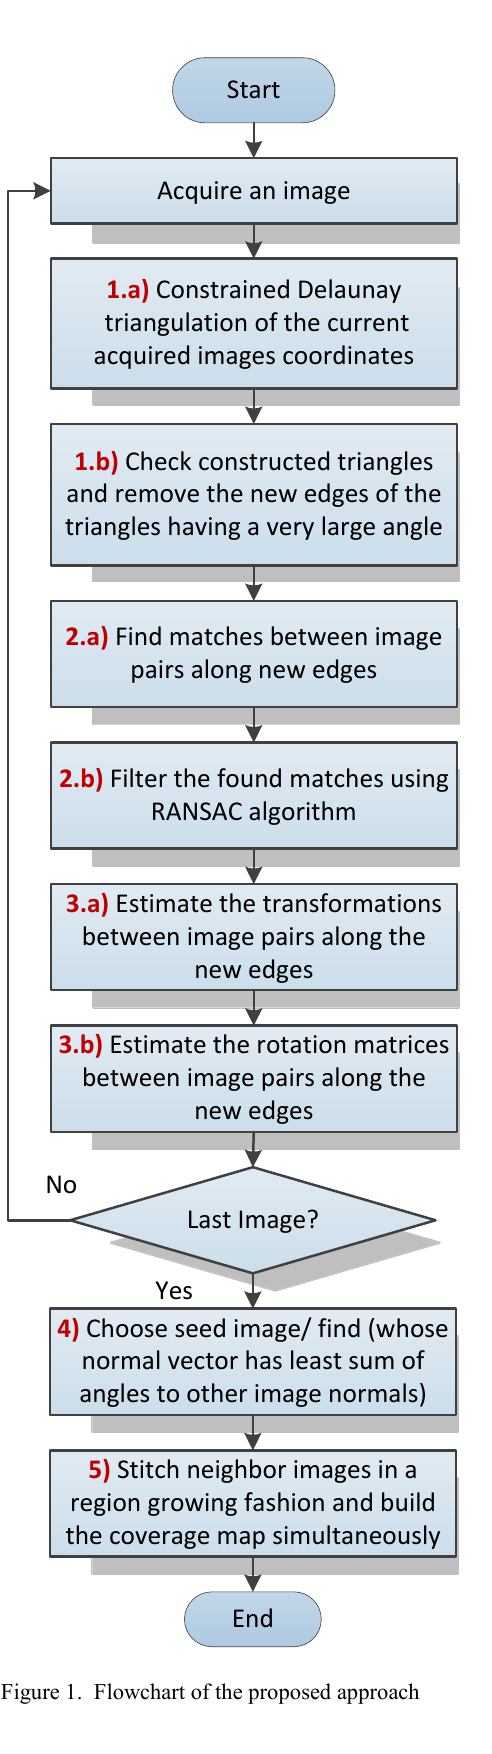
Figure 1. Flowchart of the proposed approach